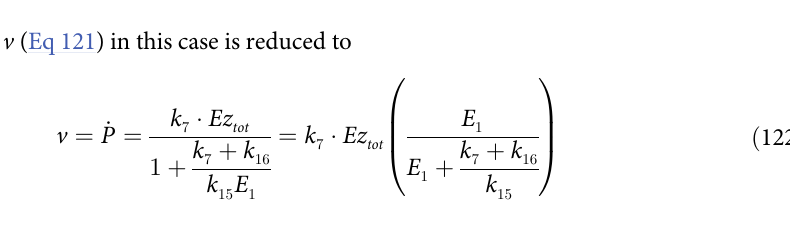
Fig 40. Scheme of the m5 controller when E 1 and E 2 are removed by a compulsory ternary-complex mechanism with E 2 binding first to Ez .